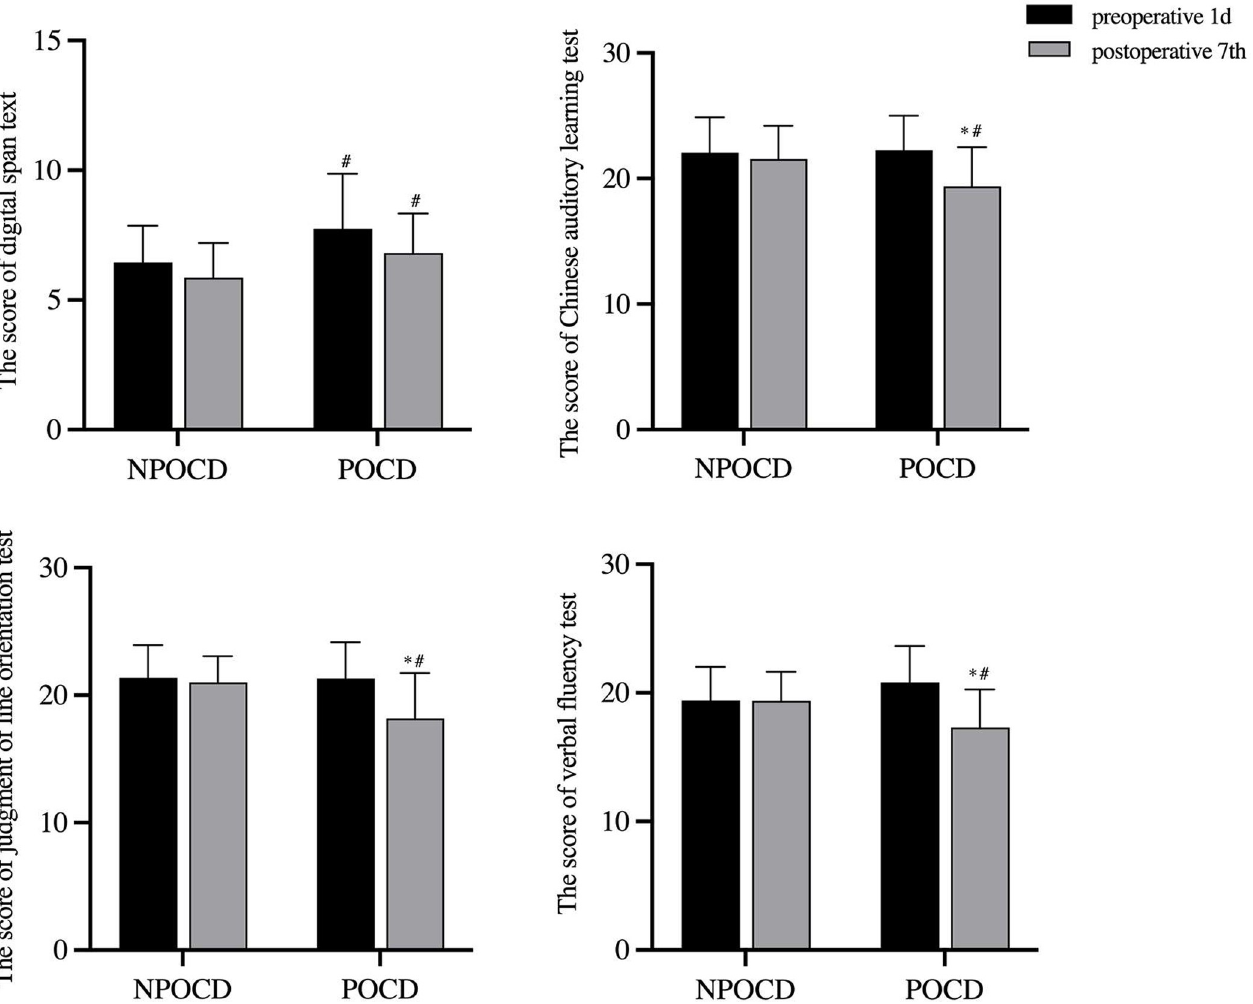
Fig 3. The neuropsychological test scores from NPOCD and POCD group. Vs 1 day before surgery, � p < 0.05, vs the NPOCD group, #p < 0.05.